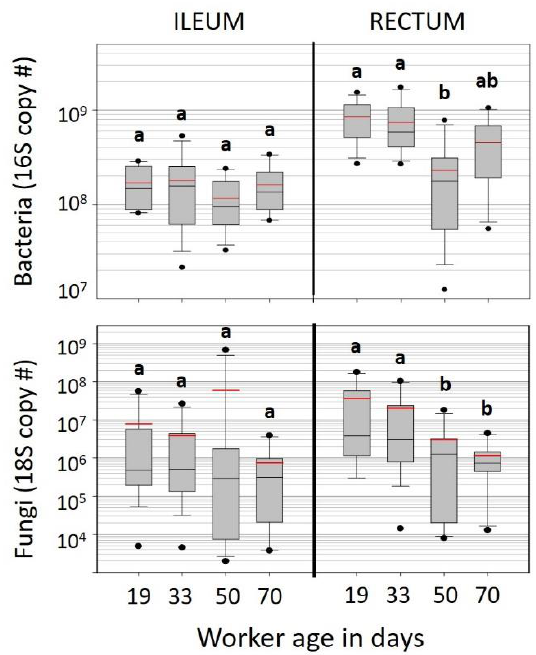
Figure 2. Box and whisker plots representing the total bacterial and fungal abundance associated with the known age (KA) ileum and rectal tissues. Workers sampled at 19, 33, 50, and 70 days of age. Box and whiskers represent 25–75% and 5–95% percent of the distribution, respectively. Each box and whisker plot represents 16 individual bee tissues. The y-axis is logarithmic scale (Log10). Different letters indicate significant differences ( p < 0.05).